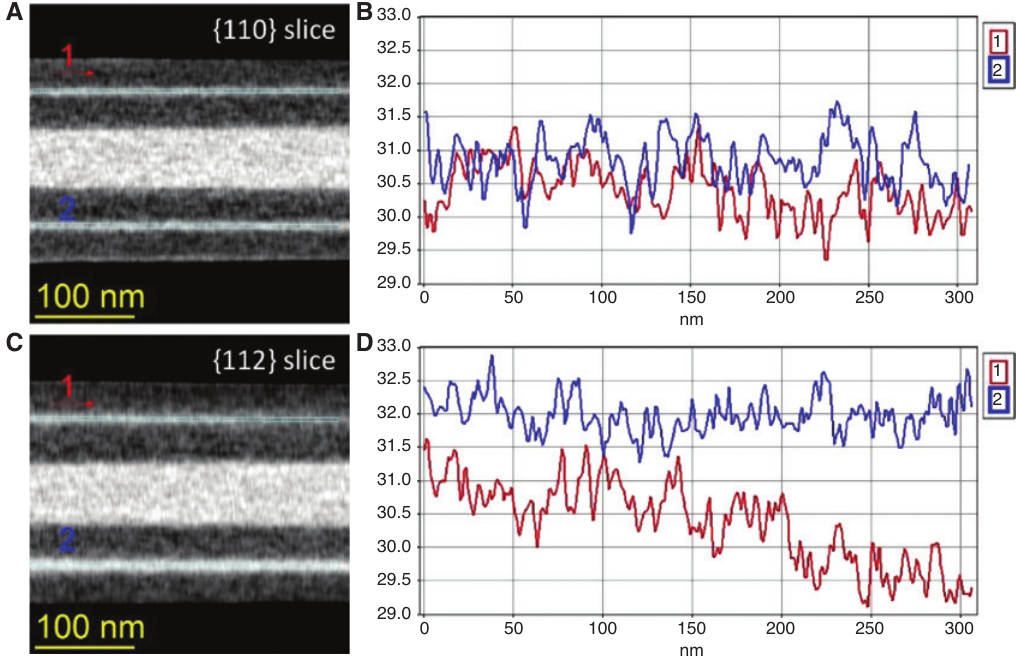
Figure 7: (A and C) Axial fluctuations in GaAs content (i.e. Al intermixing) within the QWT of the GaAs-AlGaAs core-multishell nanowire reconstructed by HAADF-STEM tomography (Figure 4) along slices parallel to the [110] or [112] planes. (B and D) Line profiles (1,2) taken at line scans inside the QWT as indicated by the 1 and 2 label in (A and C). They show deviations from Z = 32 (average atomic number of GaAs), indicating that the concentration varies locally: for example, in (D), the line profile 1 goes down until Z = 29.5, which corresponds to about 30% of Al.